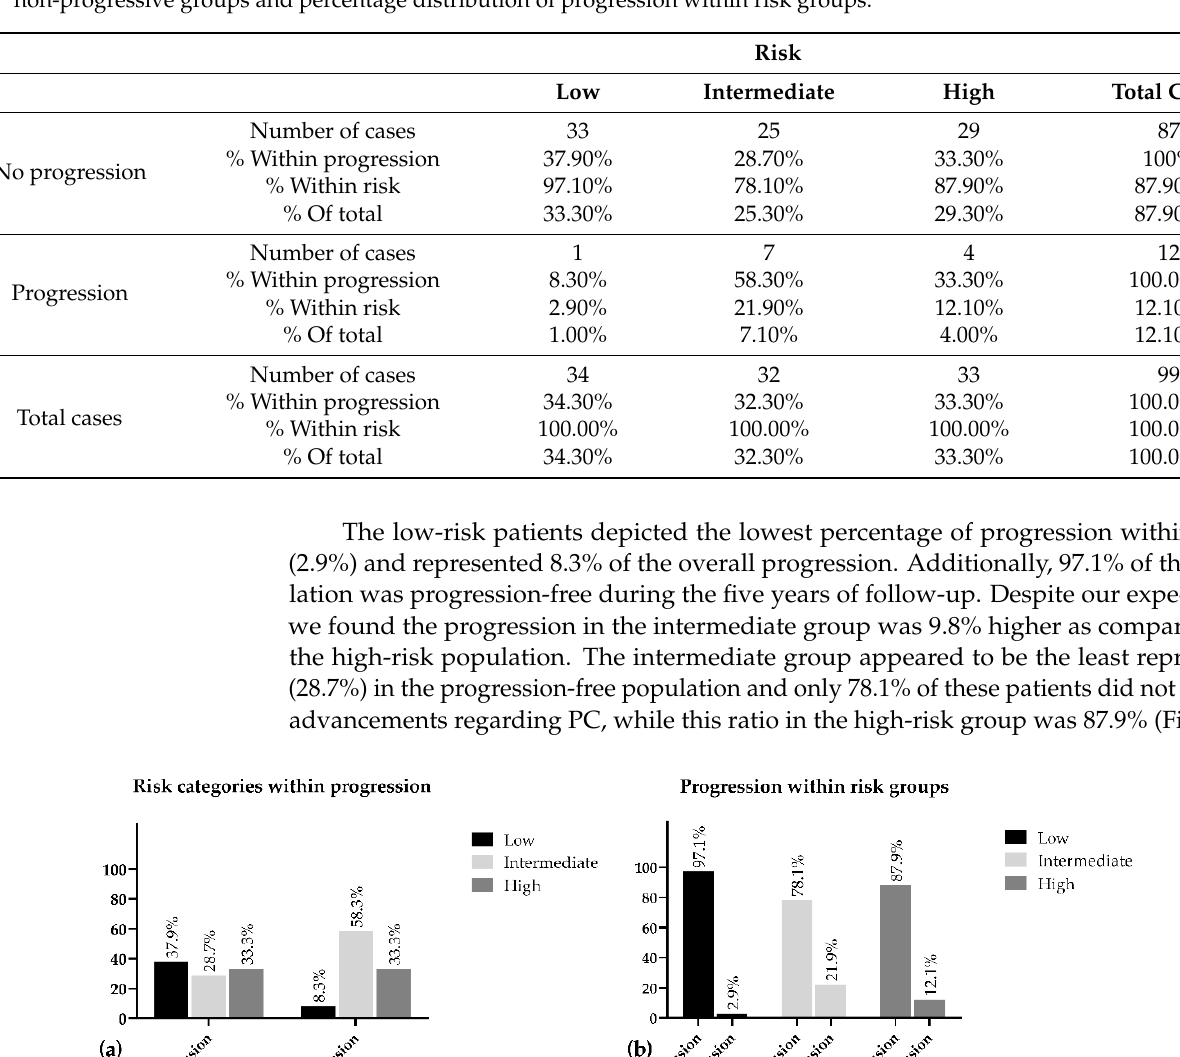
Table 1. Cross-tabulation of risk classification and disease progression. Appearance of risk categories in progressive and non-progressive groups and percentage distribution of progression within risk groups.